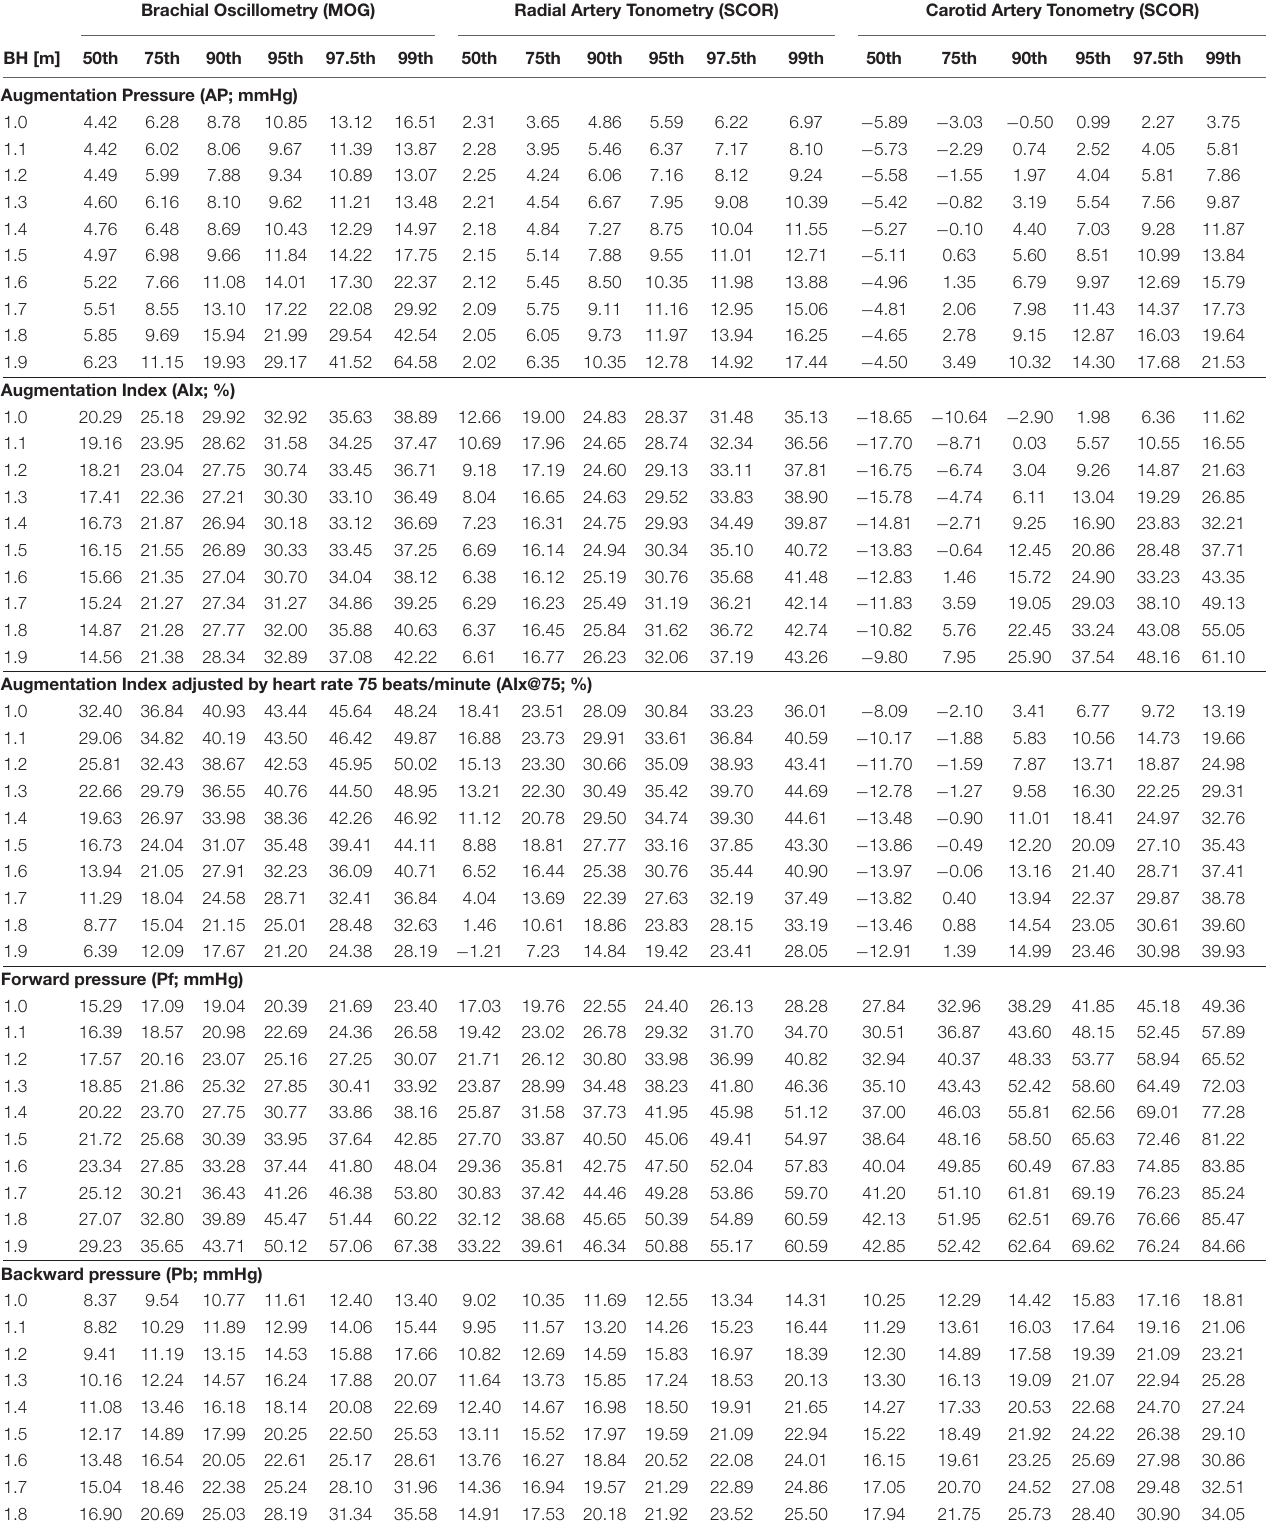
TABLE 5 | Body height-related reference intervals for central waveform-derived indexes (All: Females and Males). Brachial Oscillometry (MOG) Radial Artery Tonometry (SCOR) Carotid Artery Tonometry